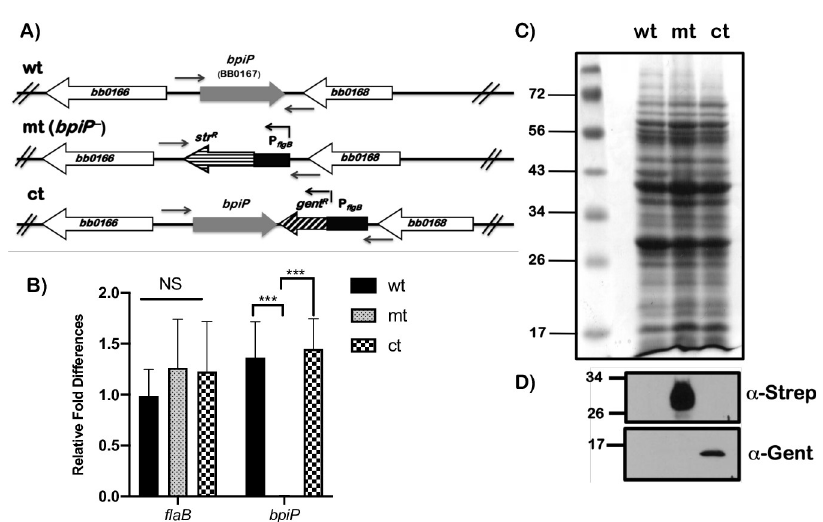
Fig 5. Generation of the bpiP mutant and complement strains. (A) Schematic representation of the genetic manipulation performed to generate bpiP ( bb_0167 ) mutant and cis-complemented strains. (B) Total RNA from wt, mt and ct grown at pH7.6/32˚C was converted to cDNA and quantitative real-time PCR was performed as described in the Materials and Methods section. The levels of bpiP transcripts were absent as expected in the mt compared the control strains. The change in the C value for each sample was subjected to an unpaired t test in GraphPad Prism t software. The asterisk indicates the levels of significance as follows: ��� p < 0.001. Total protein lysates from wt (Lane 1), mt (Lane 2) and ct (Lane 3) were separated on 12% SDS-PAGE gel and (C) stained with Coomassie blue or (D) transferred to PVDF membrane for immunoblot analysis using antibodies specific to streptomycin resistance ( α -Strep, mt) or gentamicin resistance ( α -Gent, ct) proteins synthesized due to the expression of aadA and gentR resistance genes under the control of borrelial promoter P flgB .